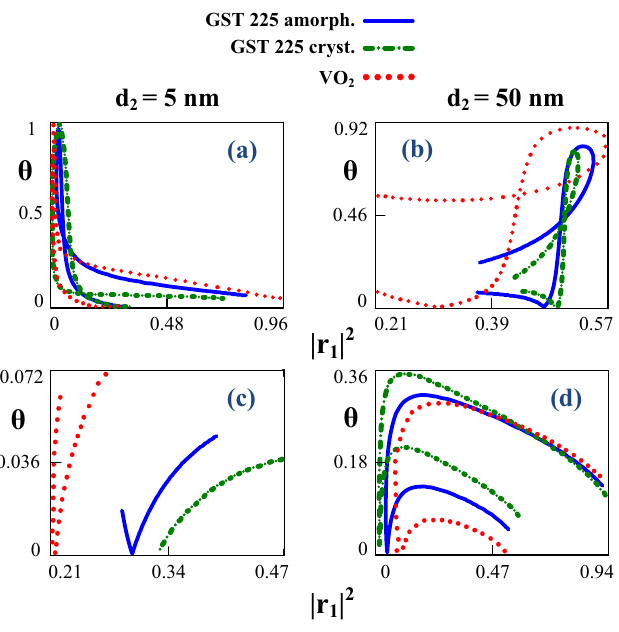
Fig. 10. Pairs of values (| r 1 | 2 , u ) realized under changing parameters e 0 b (a, b, according to the data in Fig. 5a, c, f, h) and e 0 2 (c,d,accordingtothedatainFig.8a,c,d,f)andchoiceofdifferent PCMs (amorphous and crystalline GST 225, VO 2 ) as the substrate (a, b) and main layer (c, d) material. The values of parameters are: d 2 =5nm(a,c),50nm(b,d), e 00 b ¼ 0 : 2 , m b =1(a,b), e 00 2 ¼ 0 : 2 , m 2 =1 (c, d), for all the graphs c =0, l =650nm, d 1,3,4